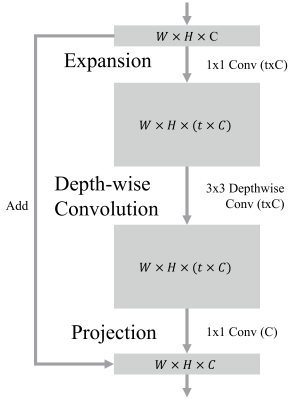
Figure 3. Structure of an IRB, which consists of three steps: expansion, depth-wise resolution, and projection. Here t represents an expansion factor, and c indicates the number of channels. The W and H are the width and height of the feature map,